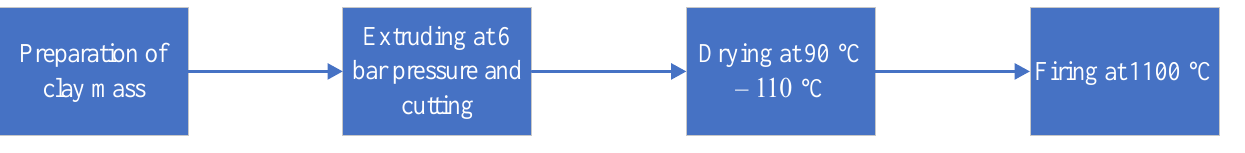
Figure 2. Production process of specimens.